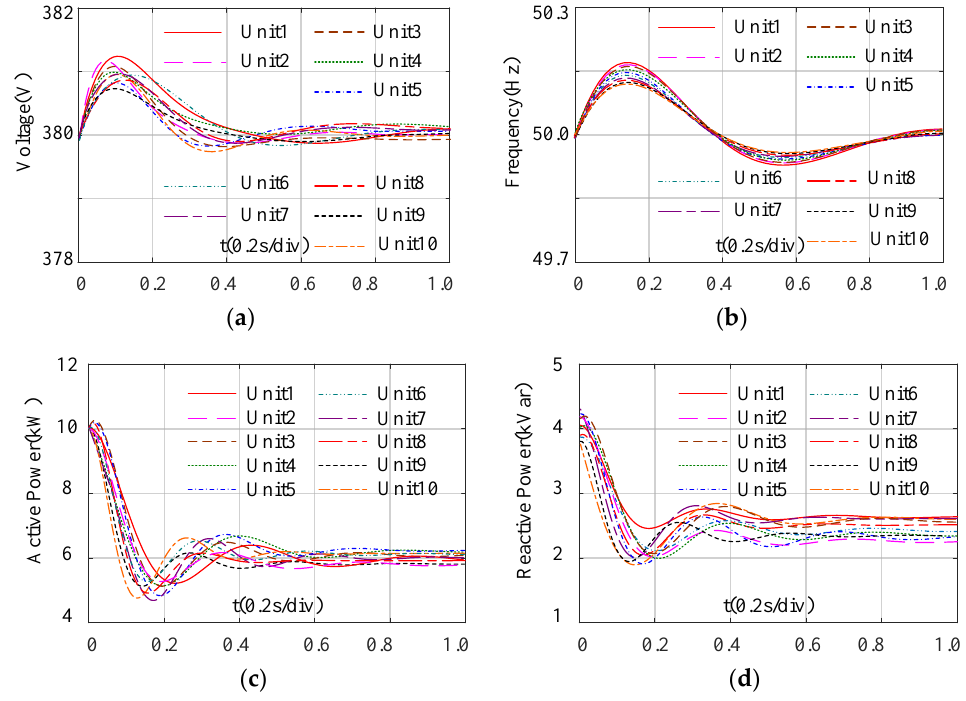
Figure 10. The simulation results with the control strategy in [25] under load change at t = 0 s. ( a )voltage amplitude;( b ) frequency;( c ) active power;( d ) reactive power.